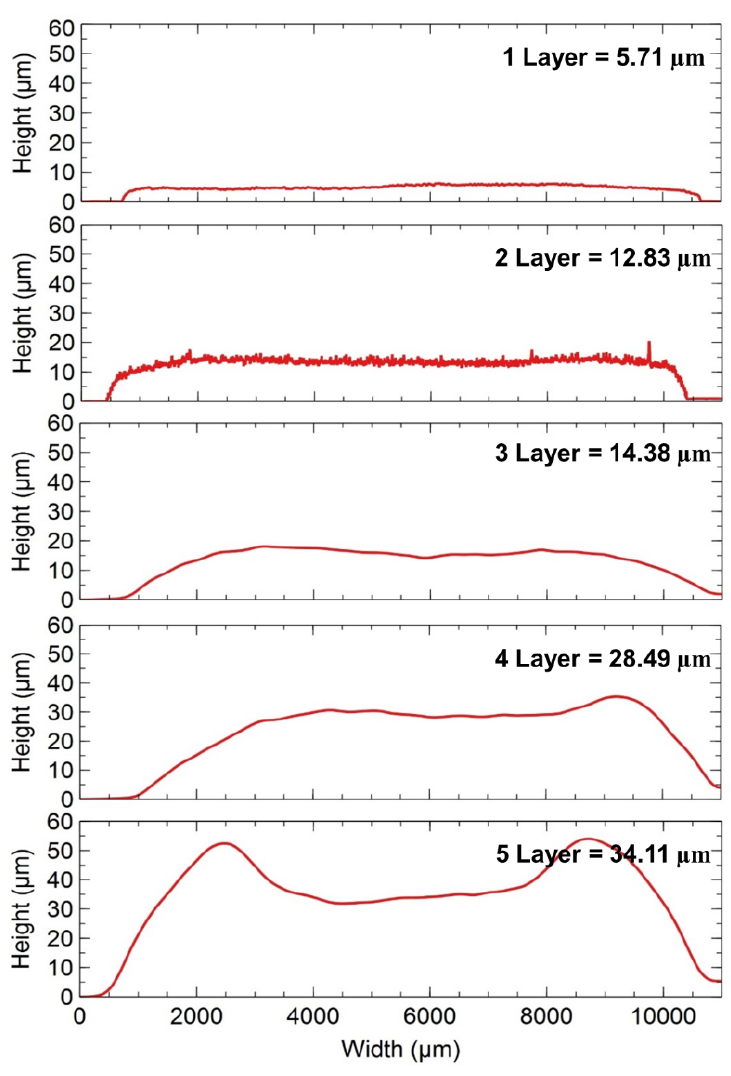
Figure 7. Height profile for different thickness TiO 2 using doctor blade method. The measured thickness using one layer of tape = 5.71 µm, two layers = 12.83 µm, three layers = 14.38 µm, four layers = 28.49 µm and five layers = 34.11 µm.